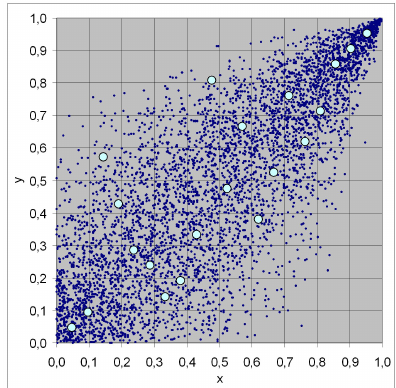
Figure 8: Symmetric negative binomial